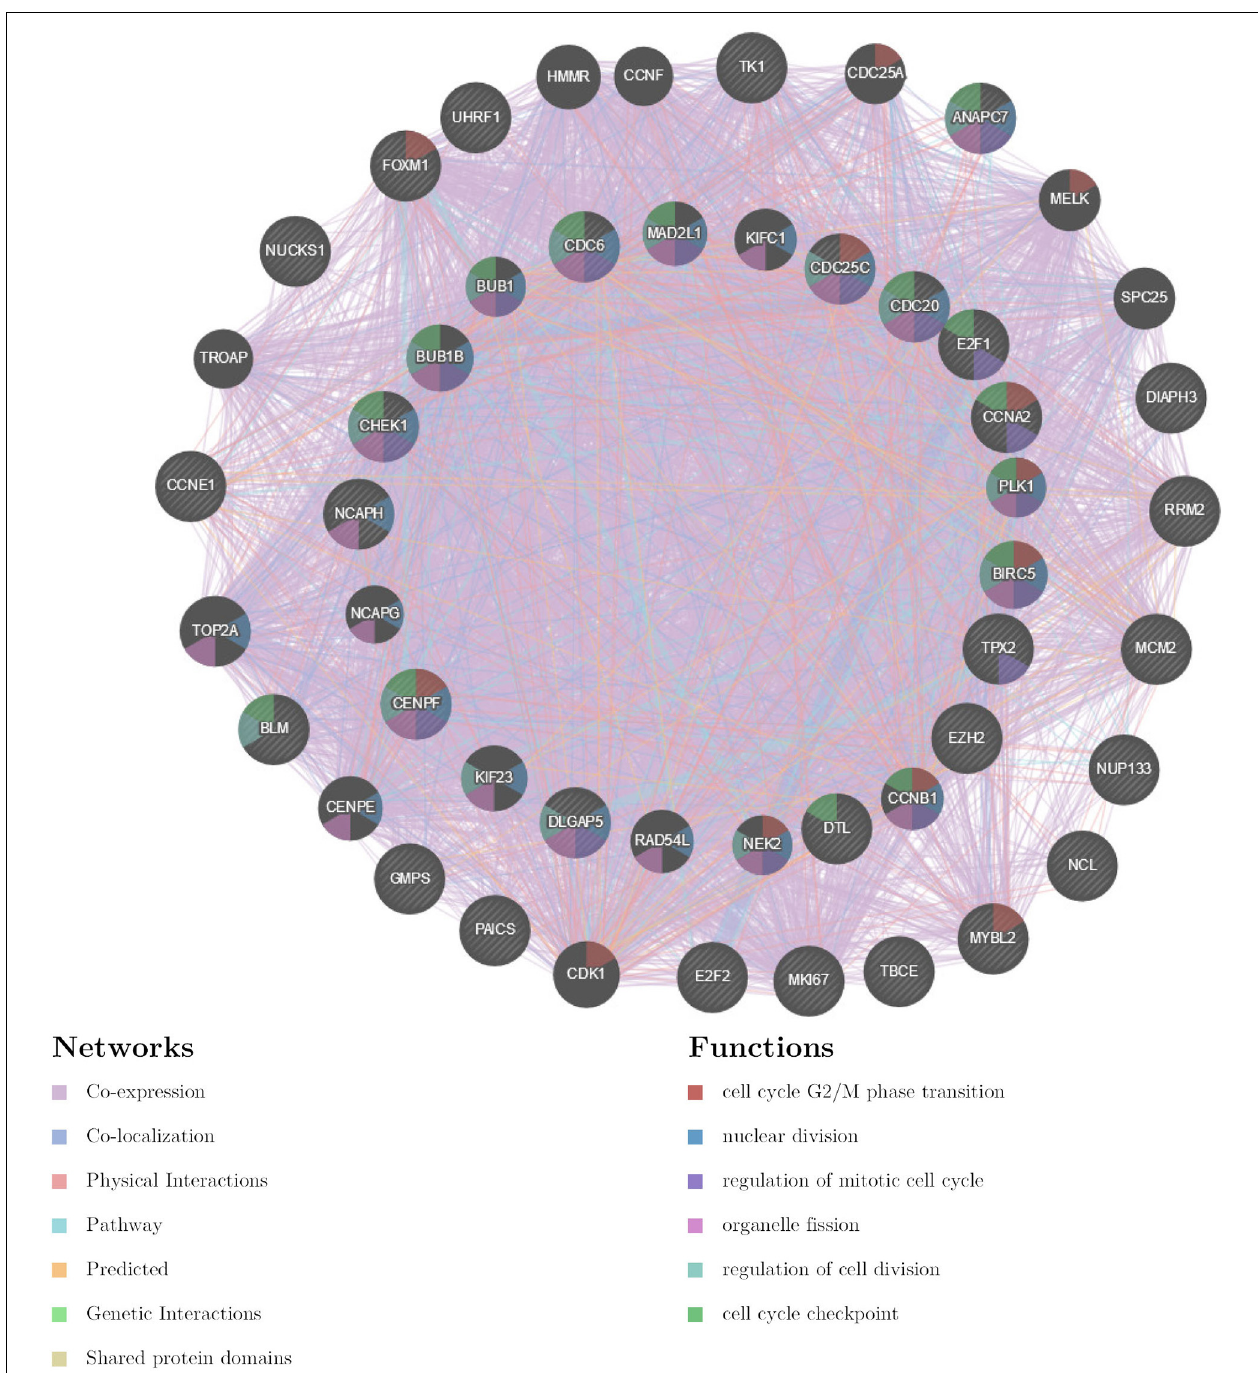
FIGURE 9 | Protein–protein interaction network of ATR kinase targets (GeneMANIA). Protein–protein interaction (PPI) network and functional analysis of the gene set enriched in targets of CDK1. Different colors of the network edge indicate the bioinformatics methods applied: co-expression, co-localization, physical interactions, pathway, predicted, genetic interactions, and shared protein domains. The different colors for the network nodes indicate the biological functions of the set of enrichment genes.